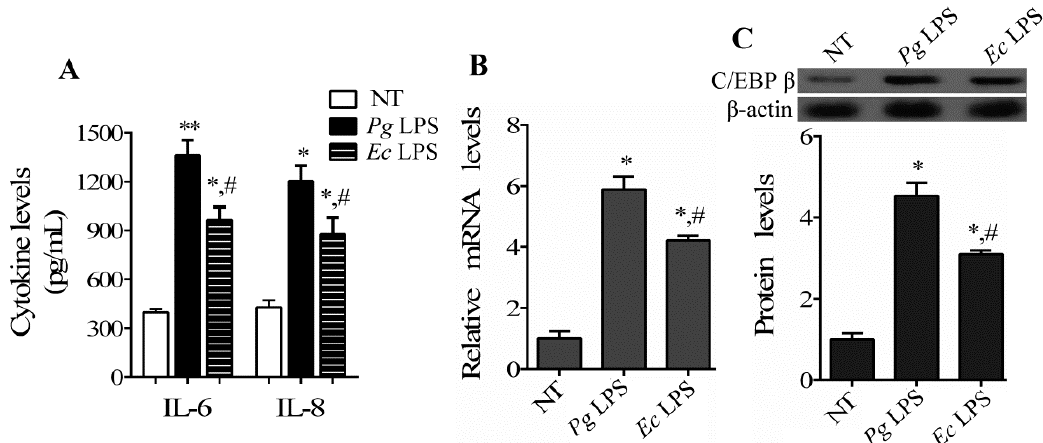
Figure 1. Expression of CCAAT/enhancer-binding protein β (C/EBP β ) gene in human periodontal ligament cells (hPDLCs) stimulated by lipopolysaccharide (LPS). ( A ) hPDLCs were incubated with 1 μ g/mL Porphyromonas gingivalis ( P. gingivalis ) LPS ( Pg LPS) or E. coli LPS ( Ec LPS) for 24 h. The levels of IL-6 and IL-8 in hPDLCs were measured using an ELISA kit; then, the mRNA ( B ) and protein ( C ) levels of C/EBP β in hPDLCs were analyzed by RT-PCR and Western blotting, respectively (* p < 0.05, ** p < 0.05 vs. not treated (NT); # p < 0.05 vs. Pg LPS).